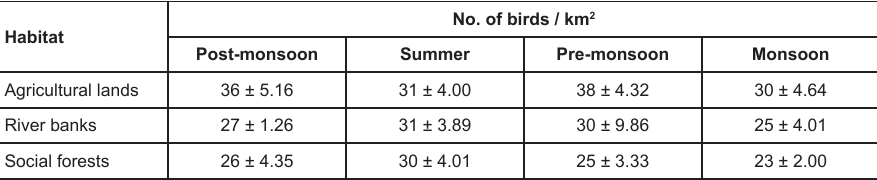
Table 2. Seasonal variations in the density of the Indian Roller in the three habitats from 2004 to 2006 . Habitat